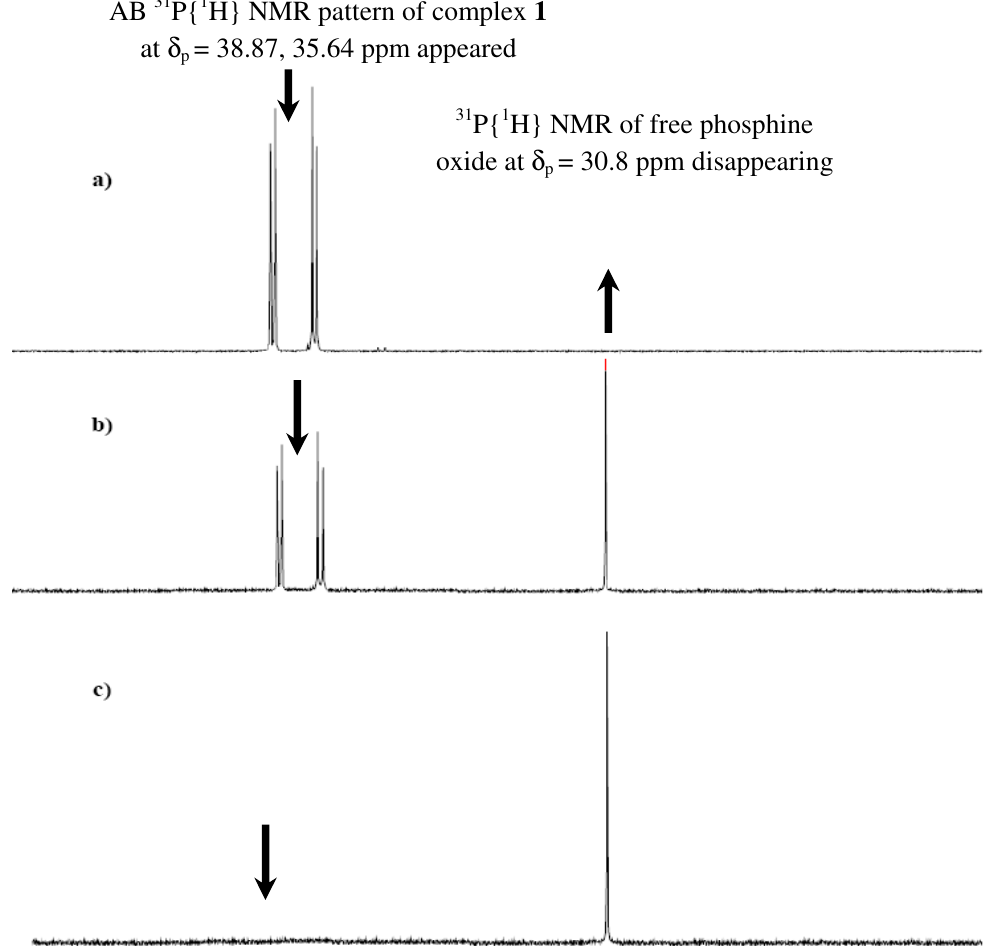
Figure 2. Time-dependent 31 P{ 1 H} NMR spectroscopic of complex 1 at δ ppm in an open atmosphere a) fresh synthesis b) after 25 min. c) after 60 min. AB 31 P{ 1 H} NMR pattern of complex 1 at δ = 38.87, 35.64 ppm appeared p 31 P{ 1 H} NMR of free phosphine oxide at δ = 30.8 ppm p